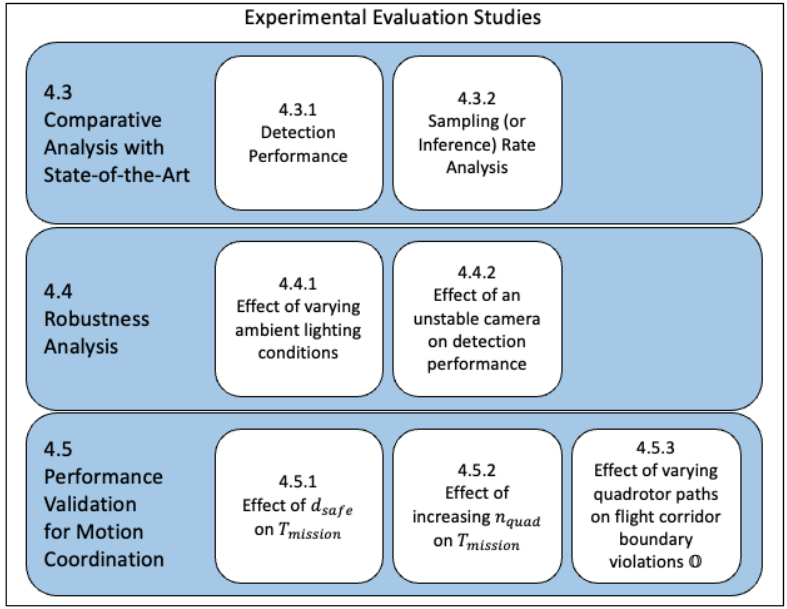
Figure 5. Three categories of experimental evaluations are presented in Section 4. These categories focus on CNN algorithm comparisons, robustness of the motion capture system to environmental conditions, and actual performance evaluation for multiple quadrotors motion